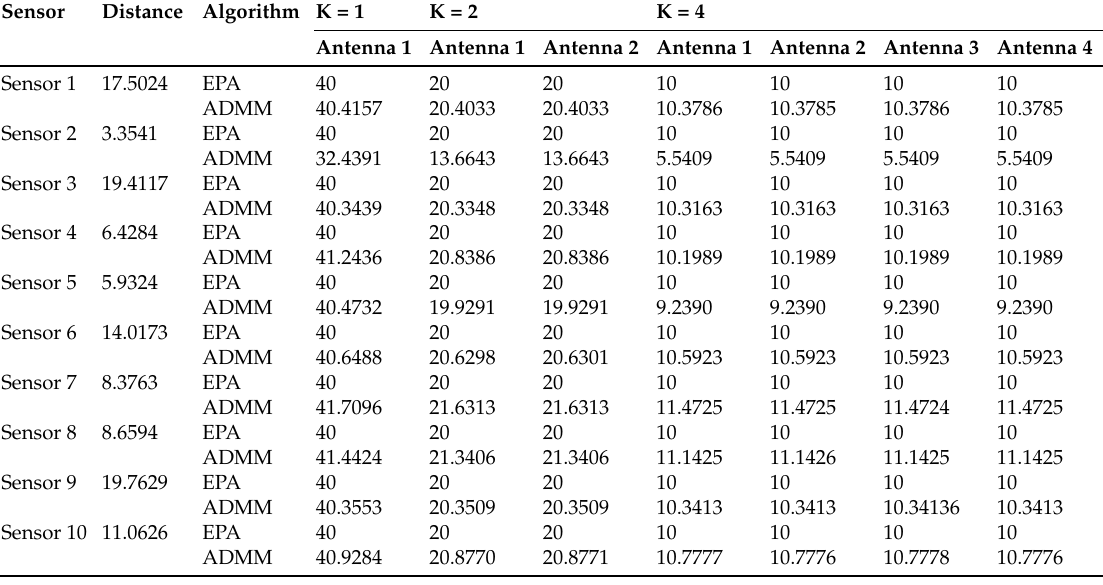
Table 1. The power allocation results of different sensors and antennas under the sum of reporting power (mW). Sensor